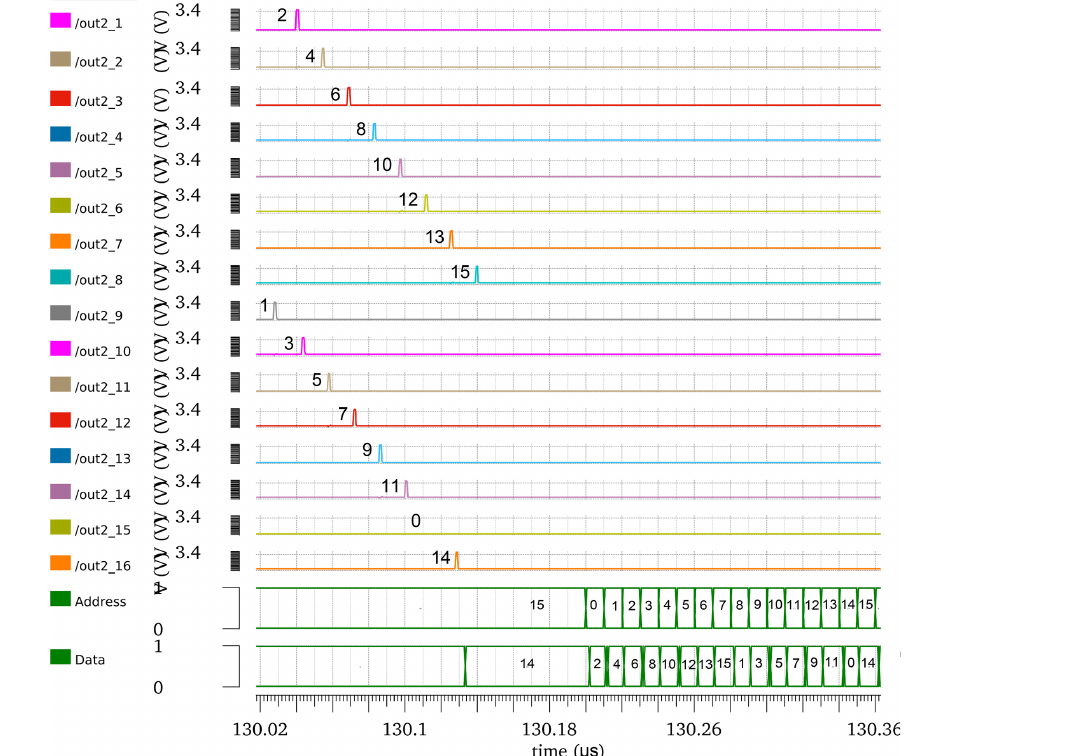
Figure 23. Simulation of the WTA and memory at 85 ◦ C. The terms out2_1 to the out2_16 represent the outputs of the WTA cells. The decoder changes the address of the memory. The data represent the order of the outputs of the WTA cells, which are saved in the memory.